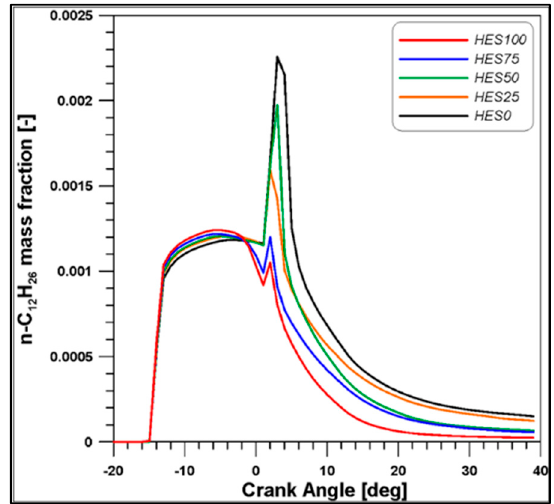
Figure 20. Diesel mass fraction.